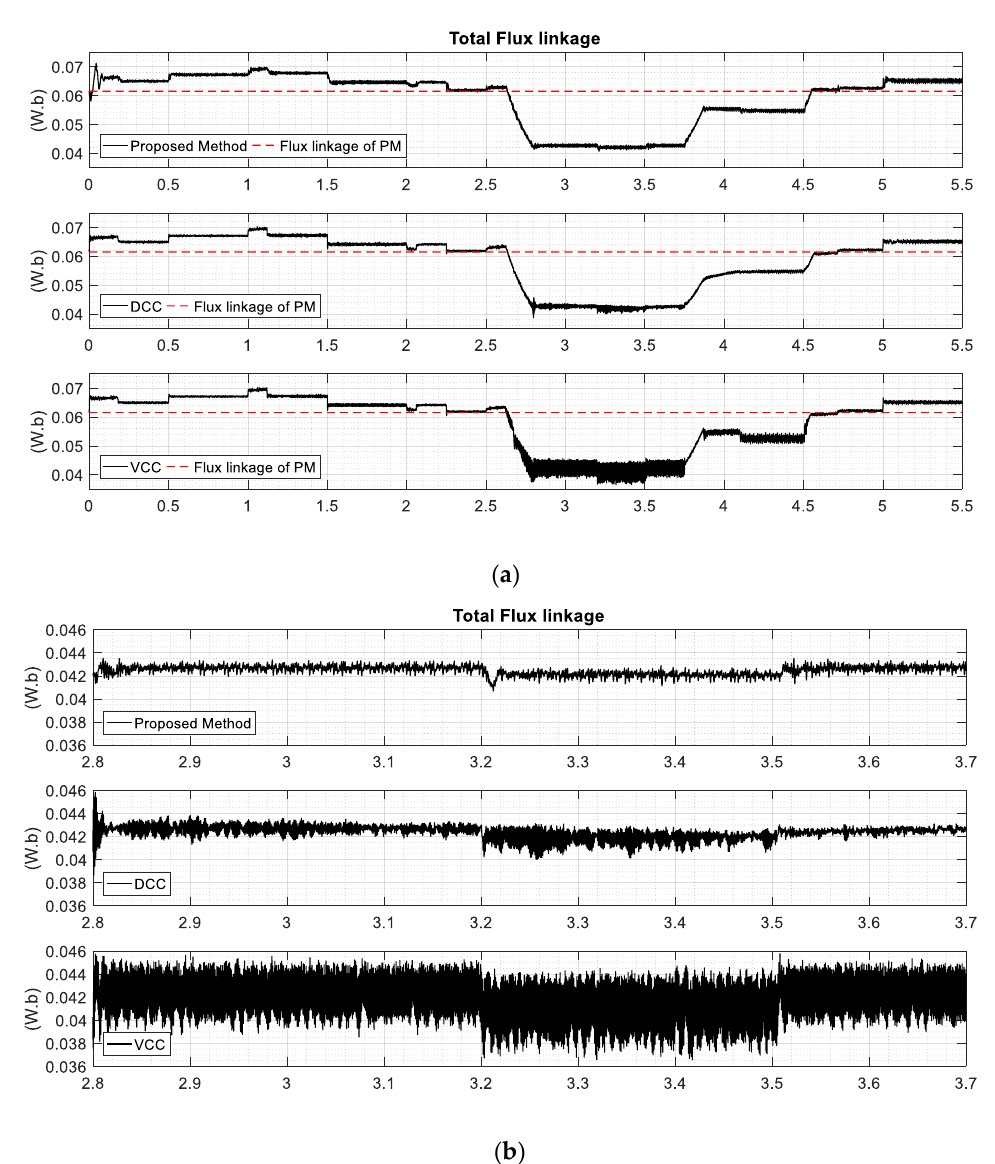
Figure 10. Comparative Total Flux linkage results of PMSM in ( a ) full simulation time range and ( b ) interval time of (2.8 – 3.7 s).